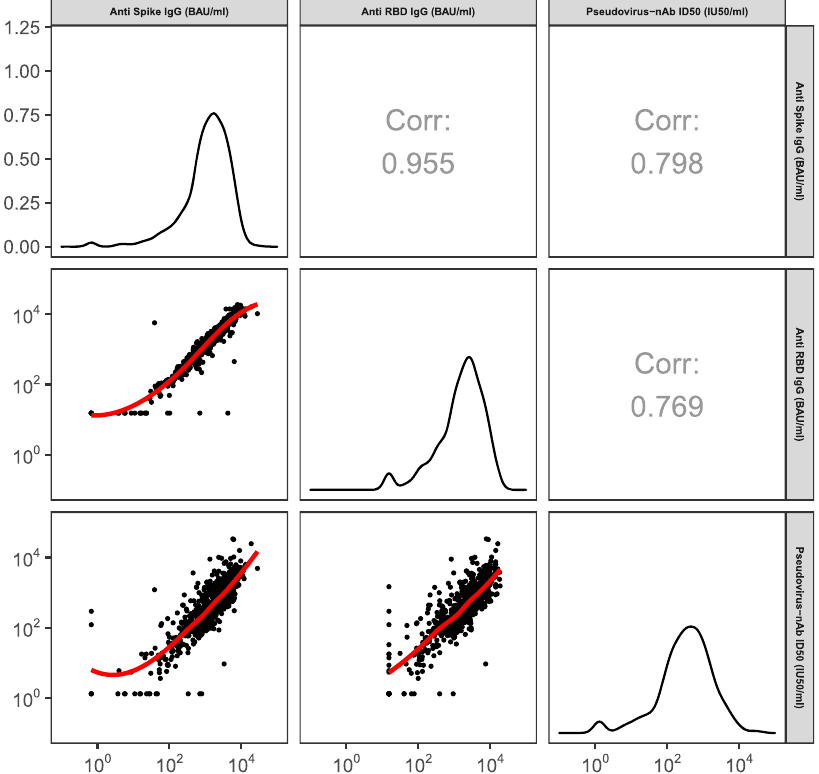
Fig.2|ScatterplotsofpairsofD35antibodymarkervalues(spikeIgG,RBDIgG, pseudovirusnAb-ID50)forbaselineSARS-CoV-2negativeper-protocolvaccine recipients in the immunogenicity subcohort (U.S. study sites). Source data are